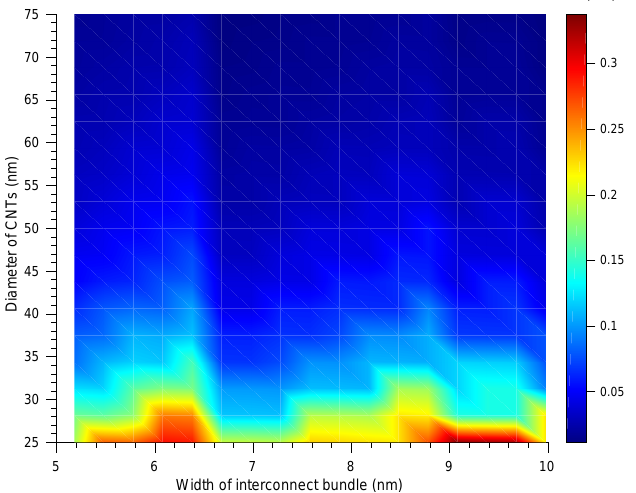
Figure 2. Synchronal variation of resistance of the squarely packed bundle of mixed CNTs from altering the width of the bundle and the diameter of the